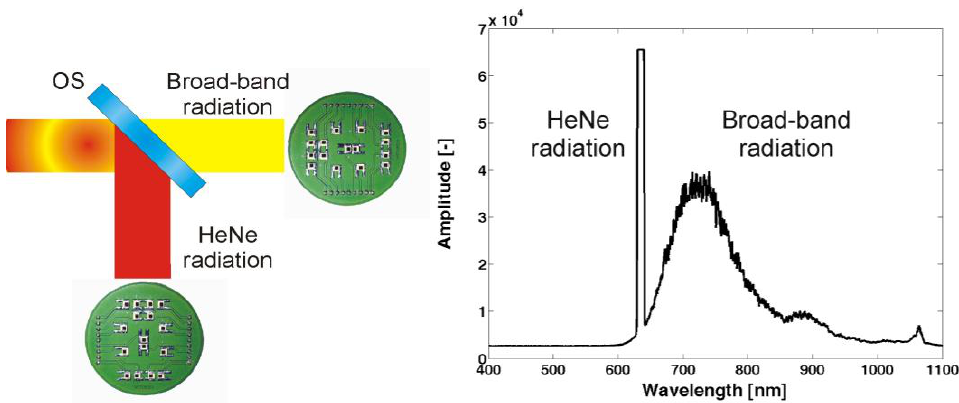
Figure 3. Detail view of the detection unit used in the designed measuring system. OS is an optical splitter. On the right hand side, there is shown a spectrum profile of the combined laser beam taken at the input of the detection unit.